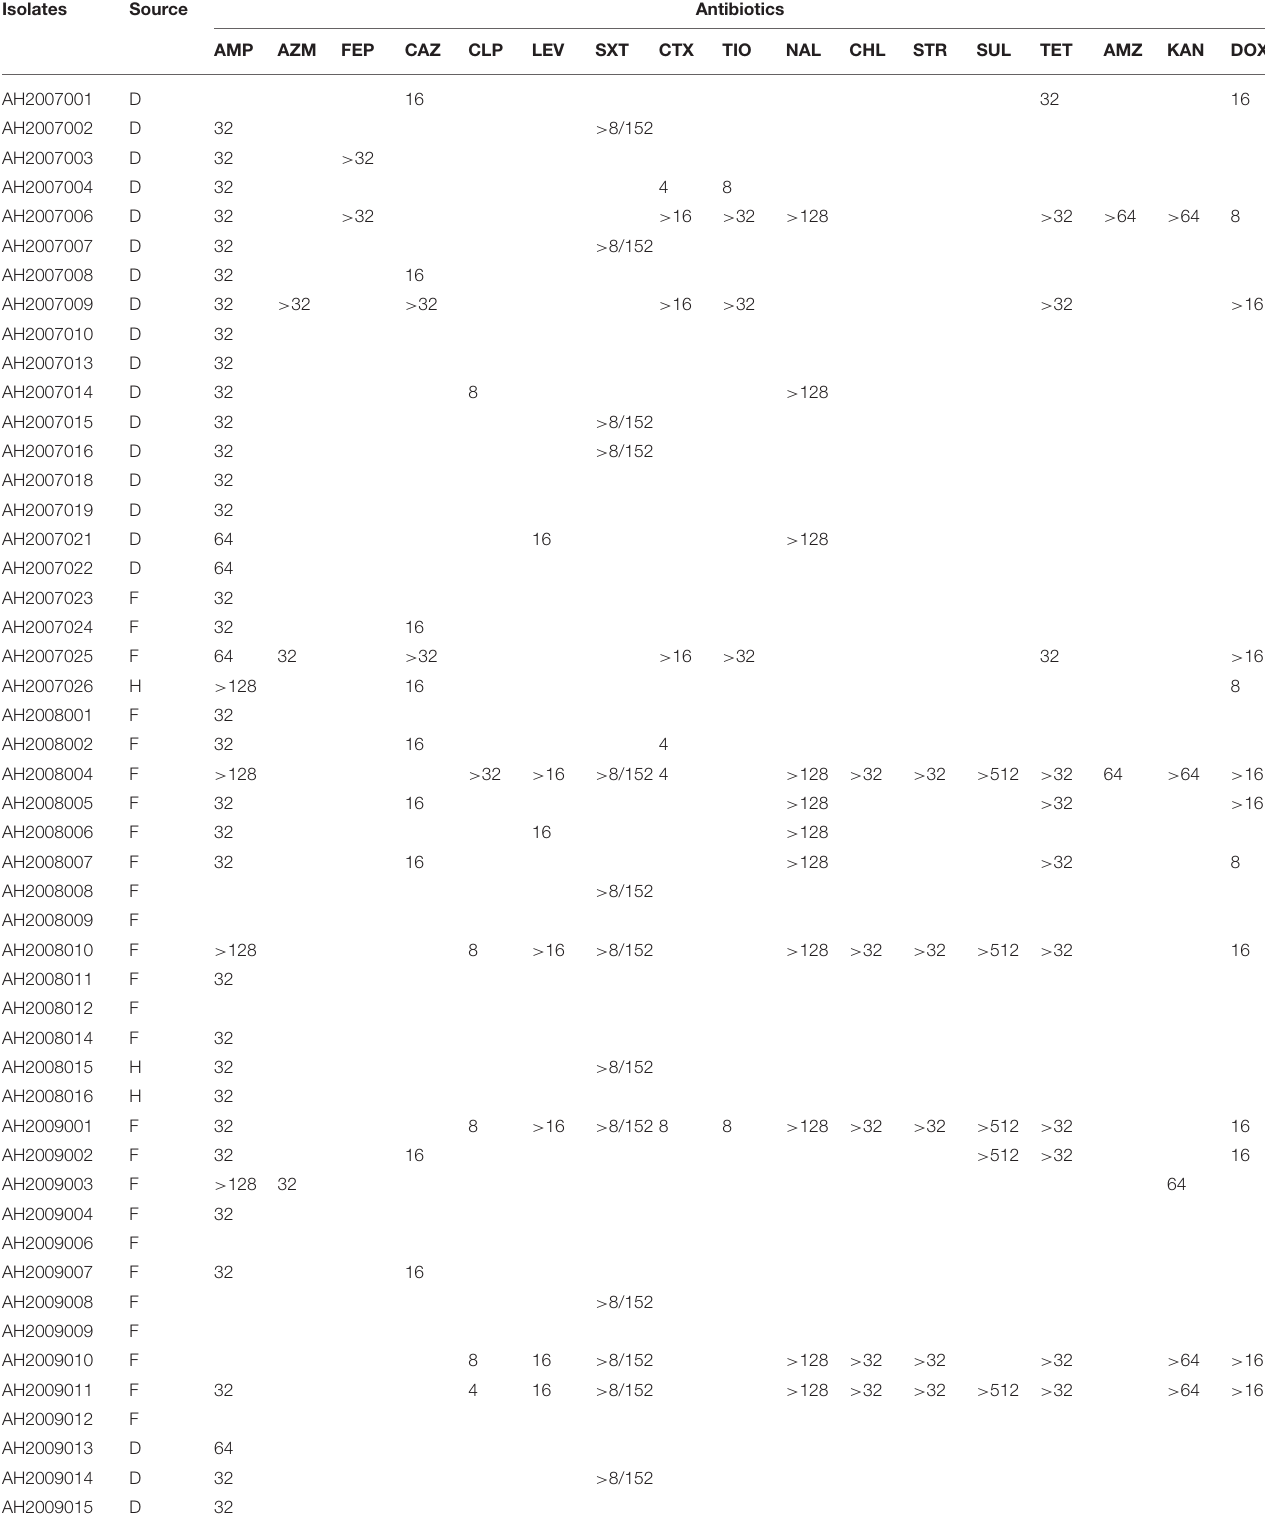
TABLE 3 | MIC values ( µ g/mL) of antimicrobial Resistance in 62 Citrobacter Isolates. Isolates